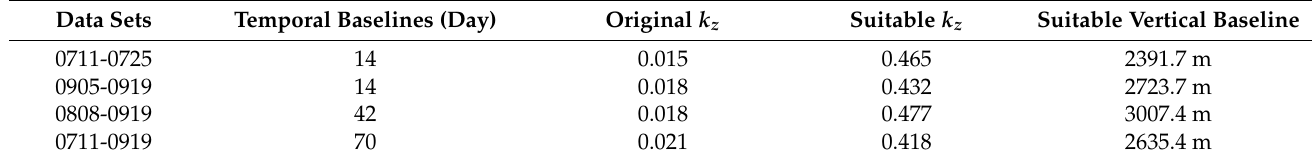
Table 5. Suitable k z for different data